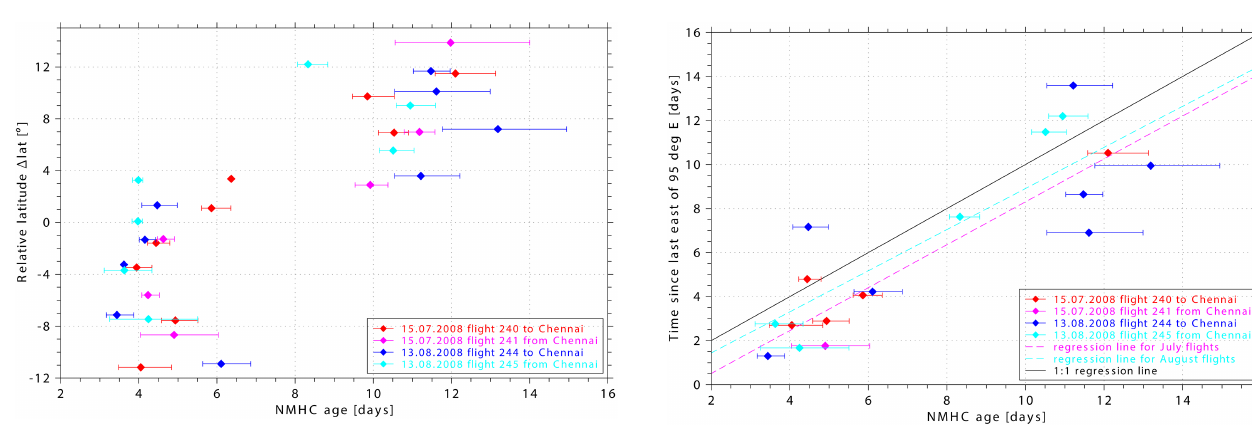
Figure 15. Comparison of the photochemical age of air estimated from NMHC ratios and the time the air had last been east of 95 ◦ E according to the FLEXPART trajectory calculations. Shown are the mean chemical age together with the minimum and maximum age determined from the propane / ethane, n -butane / ethane, and n -butane / propane ratios. The colours indicate different flights (see legend). The black line indicates perfect agreement of both age es- timates, while the dashed lines indicate linear least-squares regres- sion lines of transport time and chemical ages derived from the dif- ferent NMHC ratios (magenta regression lines for July, light blue for August